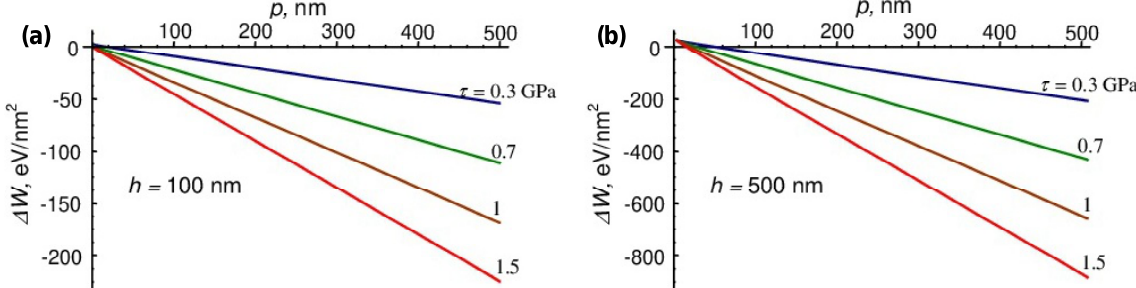
Fig. 2. Dependence of the energy difference  W on the distance p travelled by the partial b -dislocation, at various values of the shear stress  and, for the distance h =100 nm (a) and 500 nm